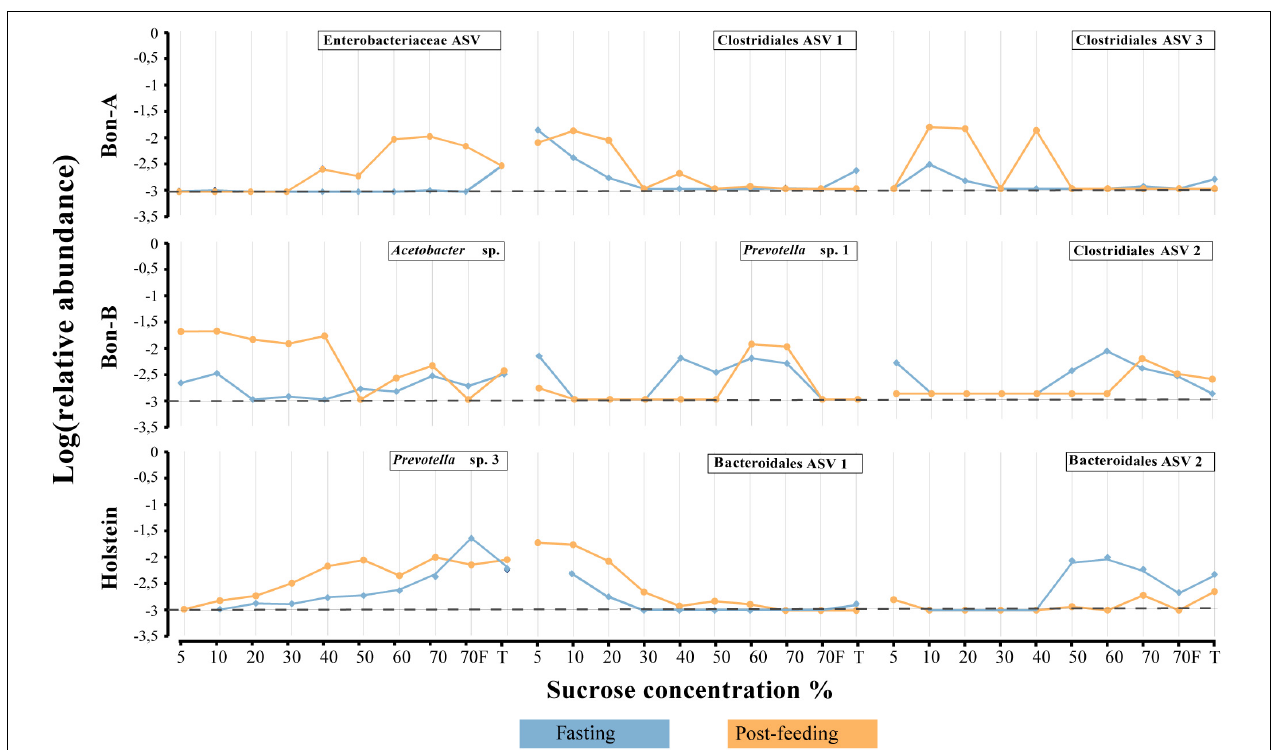
FIGURE 7 | Relative abundance of the ASVs that show their enrichment in specific fractions of the gradient when the animals were fasting or post feeding. (A) BON-A, (B) BON-B, and (C) Holstein. Blue lines correspond to the relative abundance while fasting and orange are the abundances 1 h post-feeding. Dotted black line at − 3 represents a relative abundance of 1:1,000 which marks or limit of detection for the sequencing. The relative abundance was log-transformed.